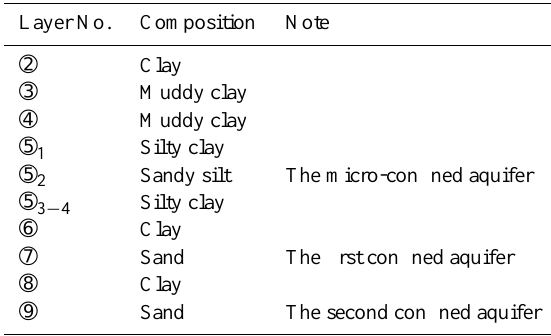
Table 1. Stratigraphic characteristics of central city in